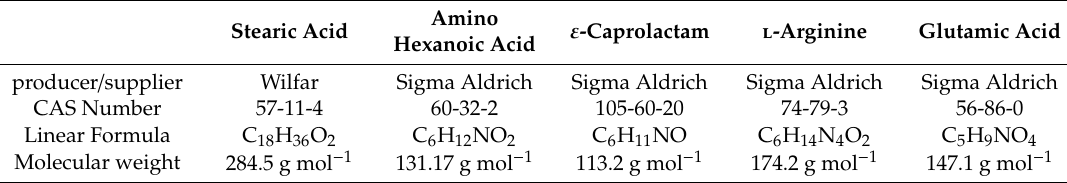
Table 2. Material specification of surface modification